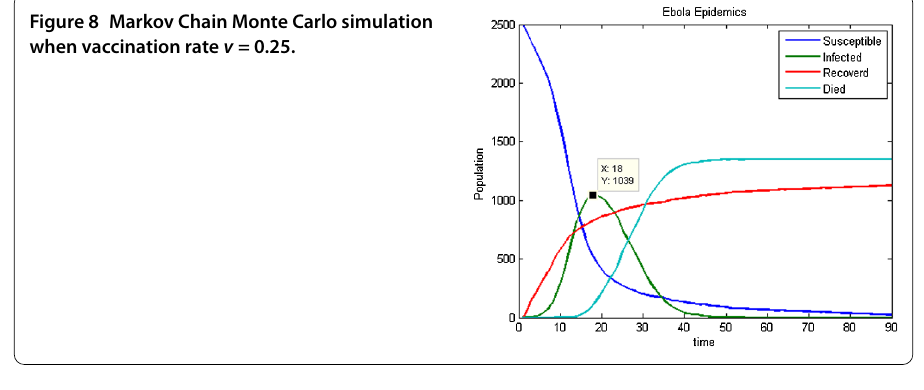
Figure 9 Markov Chain Monte Carlo simulation when vaccination rate v =